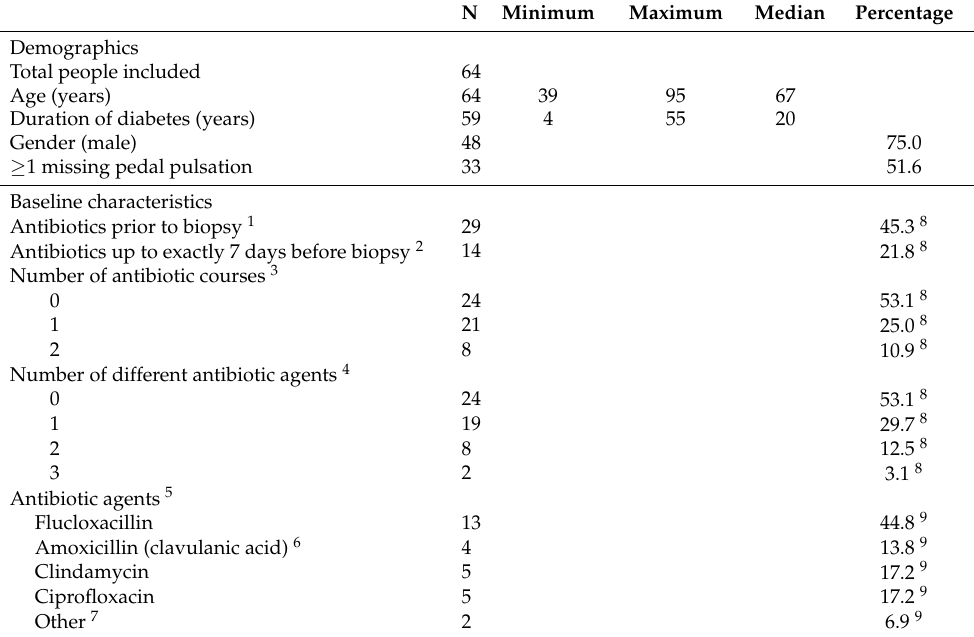
Table 1. Demographics and baseline